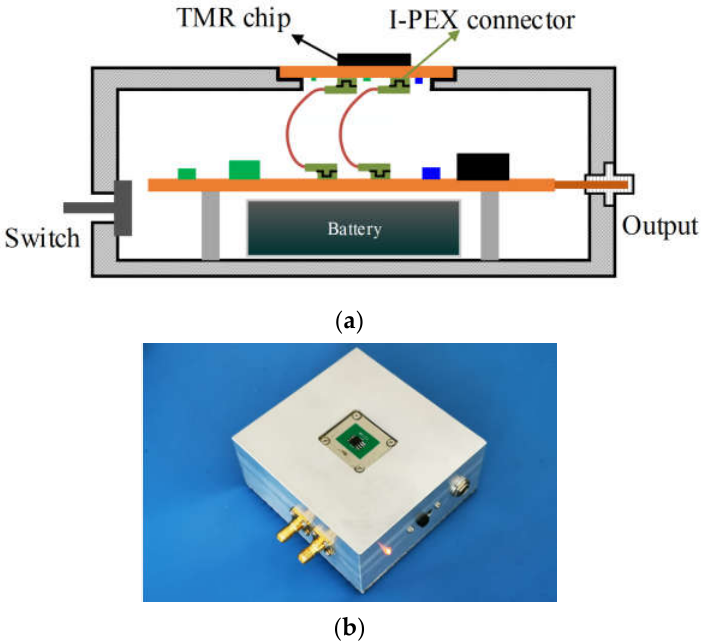
Figure 6. ( a ) Configuration and ( b ) photograph of the designed detector.